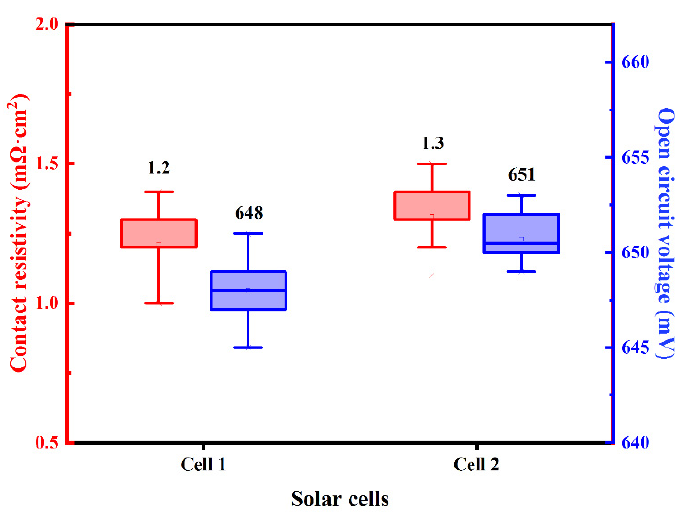
Figure 4. The distribution of the ρ c and V OC of the solar cells using Ag-Al paste and Al paste. The J 01 values of the small solar cells metallized with Ag-Al paste and firing-through Al paste using the printed pattern mentioned above are shown in Figure 5. The solar cell metallized with the firing-through Al paste yield as significantly lower J 0, metal compared with that of the cell using the Ag-Al paste. This indicates that the firing-through Al paste is a promising candidate for the metallization of the boron emitter to obtain a lower metal recombination and improved performance of N-type silicon solar cells [36].